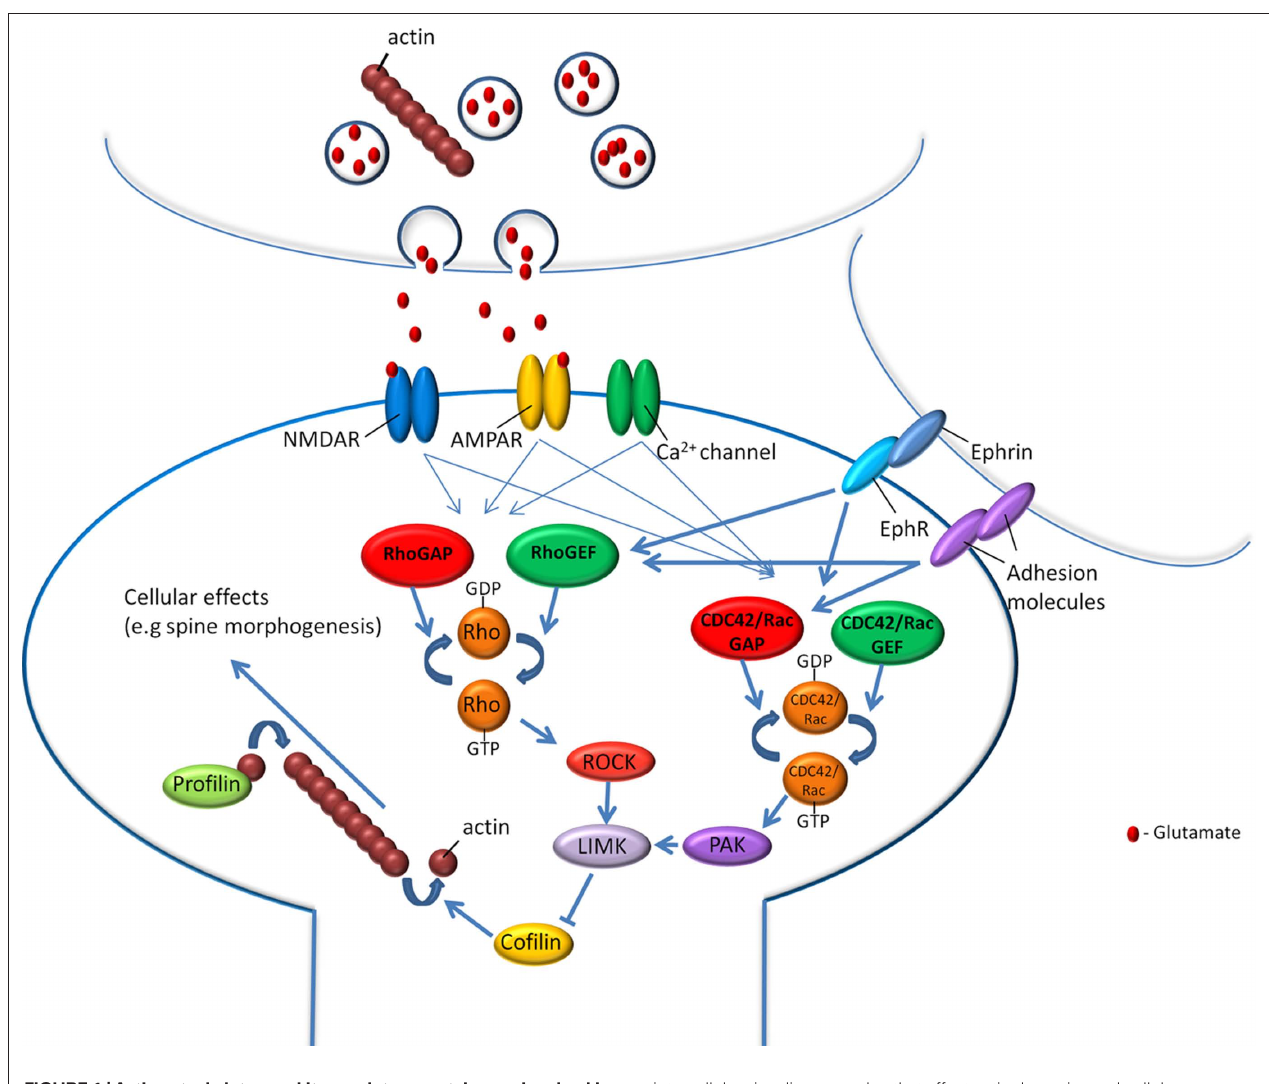
Figure 1 | Actin cytoskeleton and its regulatory proteins are involved in fear memory formation. Fear conditioning memory formation depends on the activation of glutamate receptors, calcium channels, receptors tyrosine kinases such as Eph receptors and adhesion molecules. Activation of these receptors and channels during or after fear learning may lead to regulation of